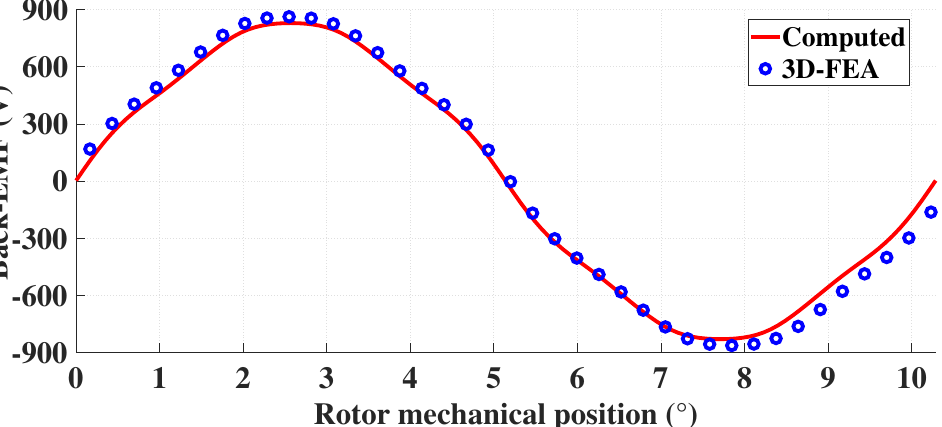
Figure 16. Computed and 3D-FEA no-load line voltage waveform as a function of rotor mechani- cal position.